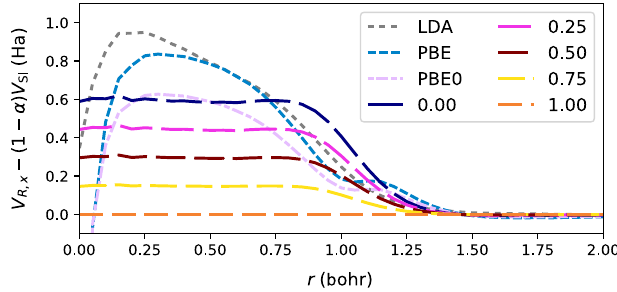
FIG. 5. Exact (inversion-based) and approximate (PBE 0 α ) step − ð 1 − α Þ V potentials V α R; obtained for the Be atom from Sl x various choices of the fraction of Fock exchange α .